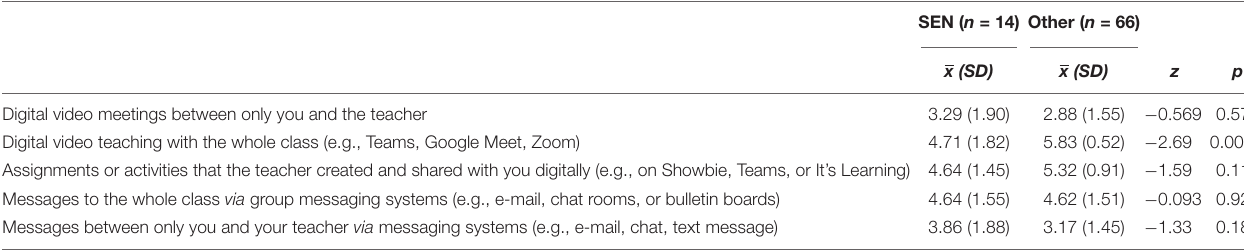
TABLE 1 | Students’ ratings of the frequency of distance learning approaches during school closings and results of between-group comparisons.